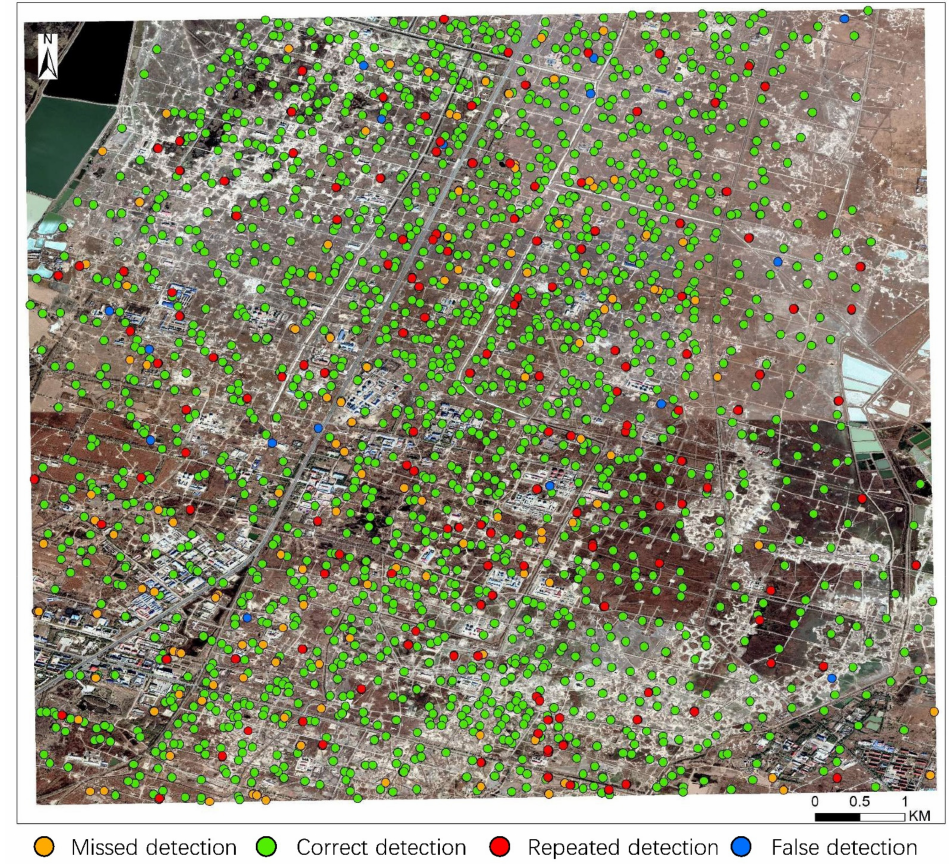
Figure 14. Detection result with unset discarding edges. However, the two experimental results indicate that the model still had the phe- nomenon of missed detection, which was caused by the following reasons: (1) a few of the oil wells were not beam-pumping wells but belt-pumping wells or other types of oil wells, which could not be detected by the current model; (2) the direction of oil well construction made the detection of some oil wells difficult. When an oil well is constructed in the east–west direction, it presents a T-like shape in the satellite image, occupies substantial pixels, and has strong features; it is easy to detect using a trained model. On the contrary, when the oil well is constructed in the north–south direction, it presents an I-like shape, occupies fewer pixels, presents unobvious features, and is easily confused with poles and mobile phone base stations, which makes them difficult to be detected (Figure